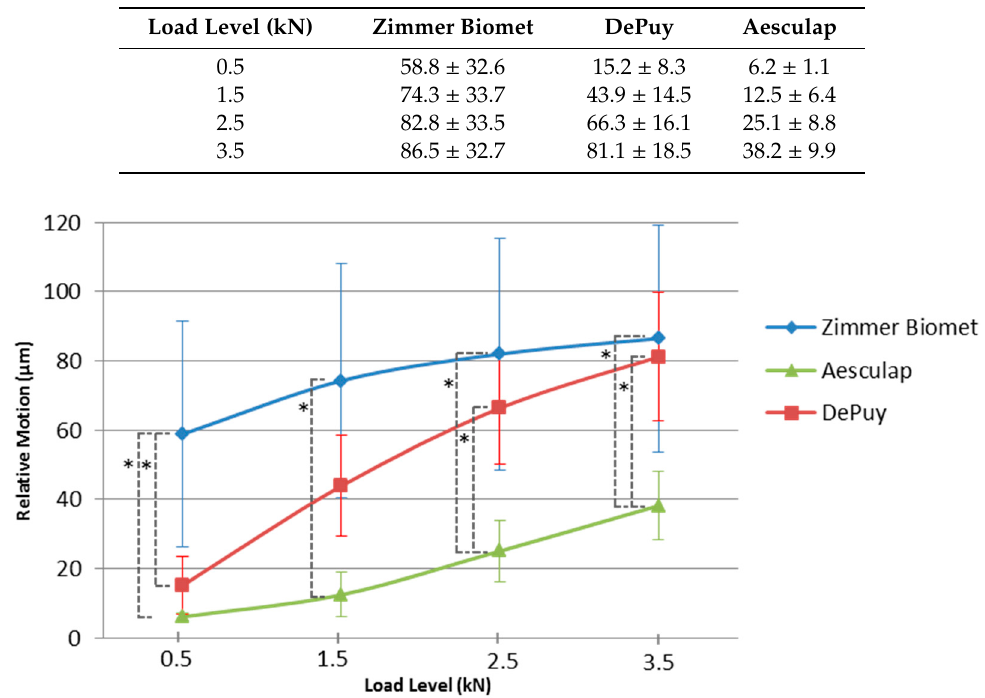
Figure 5. Resulting maximum relative motion, * showed significant difference .